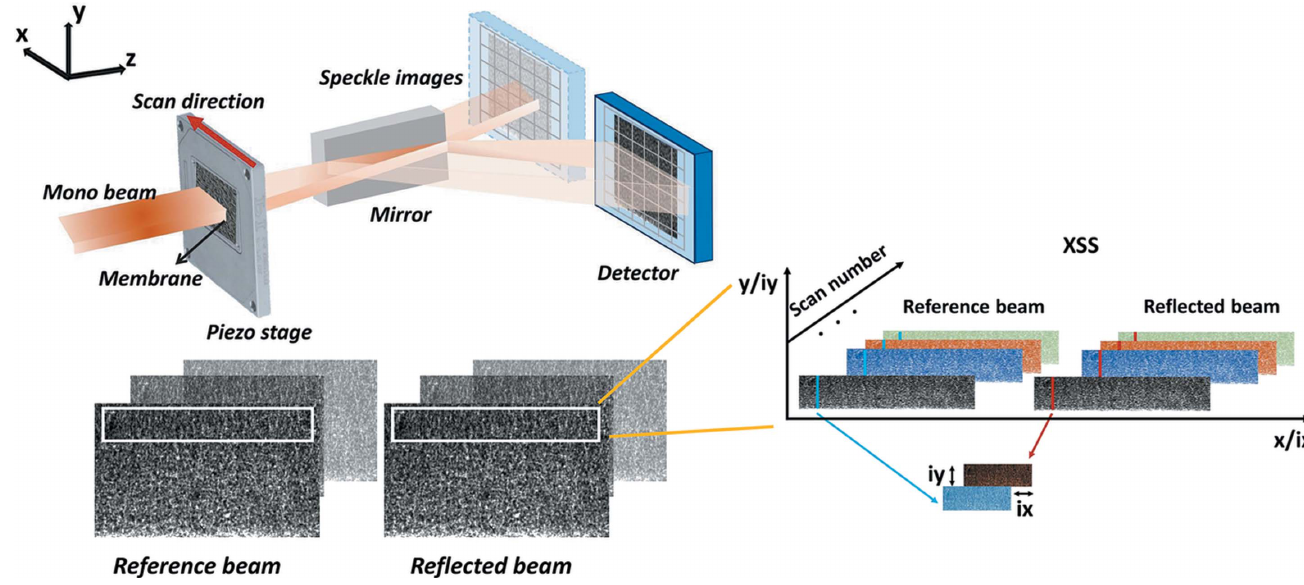
Figure 1 Experimental setup and data processing procedure for the 2D metrology of an X-ray mirror. The mirror was positioned to reflect horizontally to decouple the measurements from any vertical vibration and structure coming from the double-multilayer monochromator. The sandpaper speckle generator translated across the beam in the x direction. Two image stacks were acquired: (1) the reference beam image stack without the mirror being tested in the beam and (2) the reflected beam image stack with the mirror in the beam. Sub-regions of the raw images were selected for the 2D data analysis, as indicated by the white rectangles. In order to analyse the whole detecting area, the sub-regions were shifted to cover the full extent of the raw image. Column-by-column analysis was conducted in each sub-region. One column of pixels from each image in both image stacks was extracted and stitched together to form two new images, as shown on the right. The two new images were then used in a cross-correlation calculation to obtain the displacements in two directions, iy and ix . The 2D map of the displacements was generated by calculating the results for all of the columns within one sub- region and then shifting the sub-region to cover the whole raw